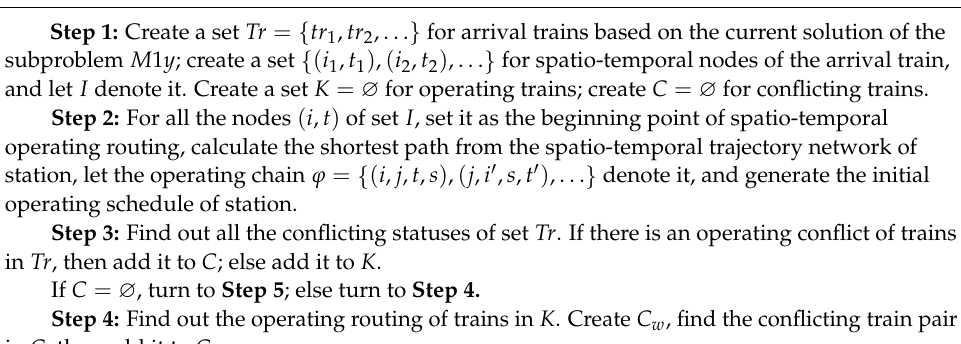
Algorithm 2: Shortest path